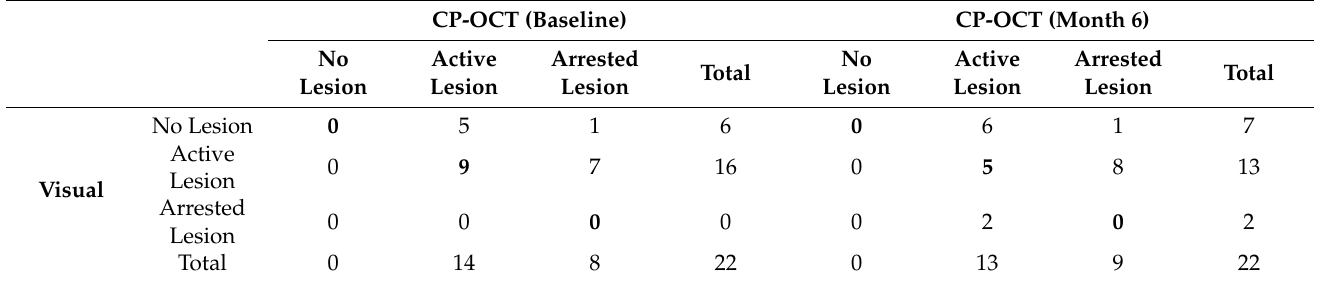
Table 1. Contingency table comparing visual assessment of the digital images of the 22 lesion areas to the CP-OCT images at baseline and at 6 months. The diagonal elements (bold) of the contingency table show the number of visual assessments that match the CP-OCT